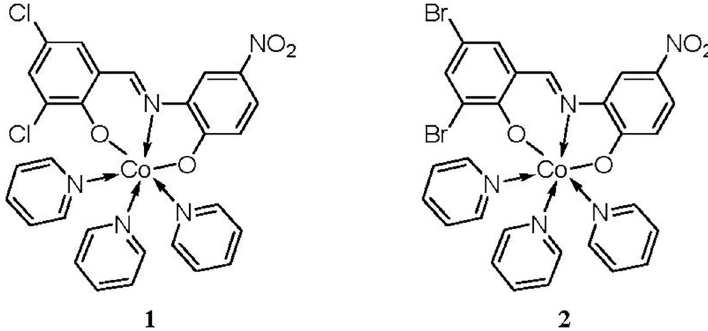
Figure 1. Scheme representation of compounds Py 3 CoL 1 (1) and Py 3 CoL 2 (2).